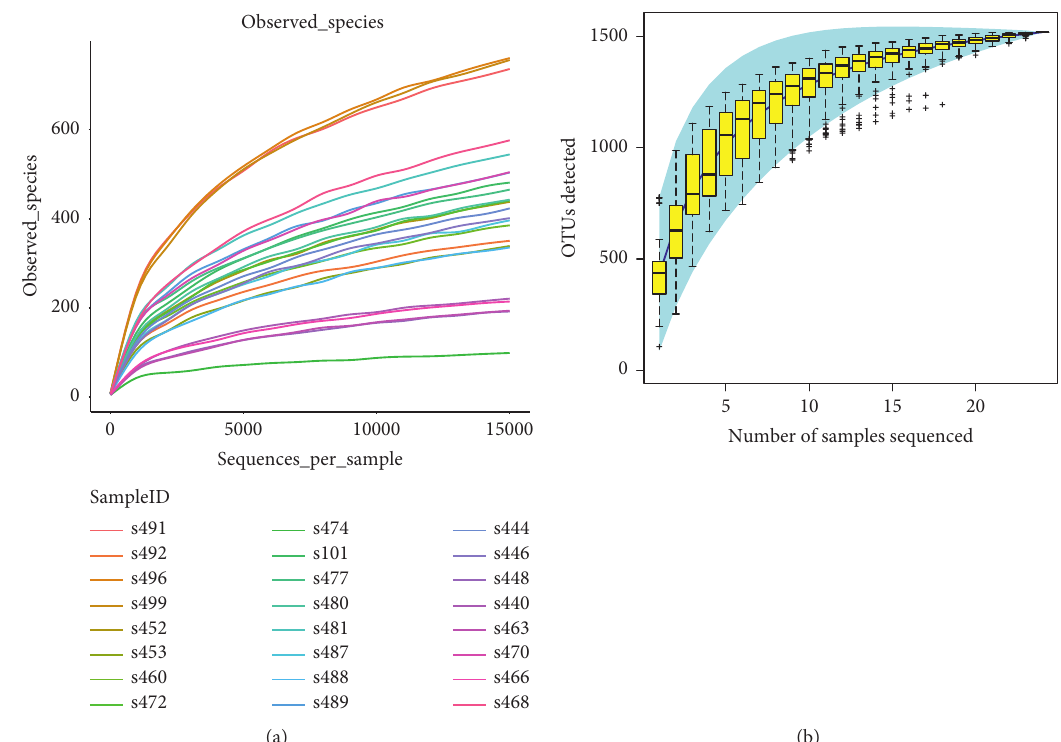
Figure 3: Rarefaction curves species (a) and accumulation curves (b) OTUs clustered at 97% sequence identity of all the